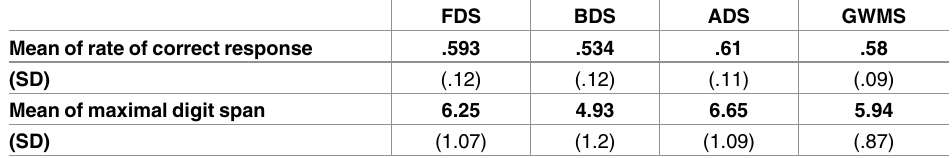
Table 2. Working memory